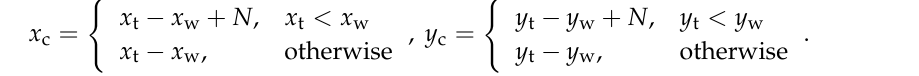
image (128 pixels); ( b ) feature matching.